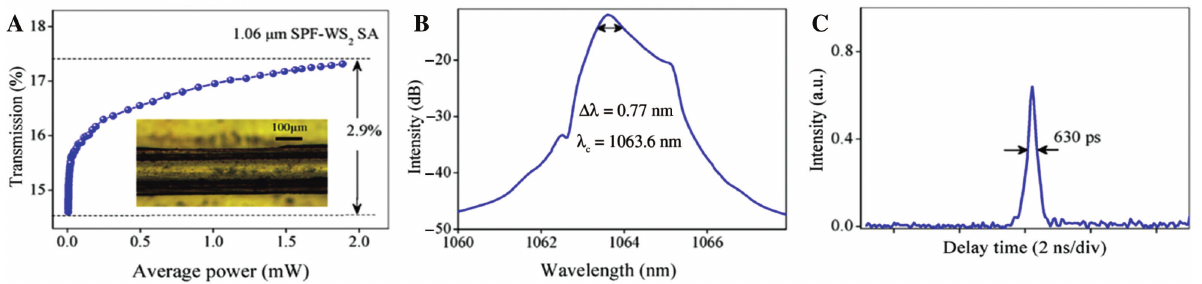
-D-shaped fiber (DSF) saturable absorber (SA). 2